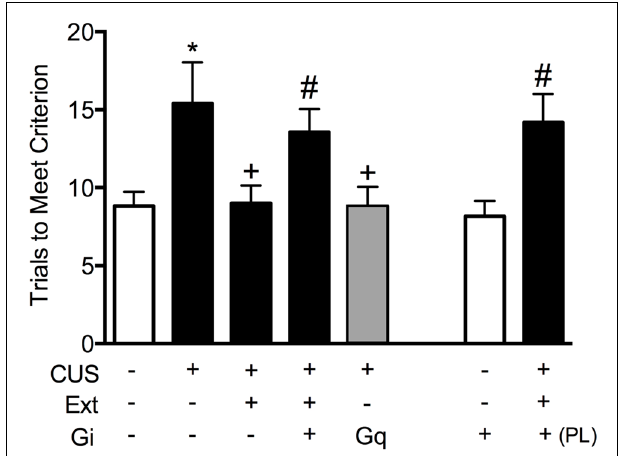
FIGURE 2 | Activity of glutamatergic pyramidal cells in the infralimbic (IL) cortex is necessary and sufficient for the therapeutic effects of extinction on cognitive set-shifting compromised by chronic stress. CUS compromised cognitive flexibility, significantly increasing trials required to meet criterion (TTC) of six consecutive correct responses on the extradimensional (ED) set-shifting task ( ∗ p < 0.05, GFP/CUS/tone controls compared with GFP/unstressed/tone controls). Both extinction treatment and hM3Dq activation with clozapine-N-oxide (CNO) reversed the effect of stress, restoring TTC to unstressed control levels ( + p < 0.05, GFP/CUS/extinction and hM3Dq/CUS compared with GFP/CUS/tone controls). hM4Di-mediated inhibition of IL projection neurons during extinction treatment prevented the therapeutic effect of extinction on set-shifting after CUS, as TTC were comparable to GFP/CUS/tone controls ( # p < 0.05, hM4Di/CUS/extinction compared with GFP/CUS/extinction). Similarly, inhibiting glutamatergic neurons in prelimbic (PL) cortex during extinction also prevented the beneficial effect on set-shifting ( # p < 0.05, hM4Di in PL/CUS/extinction compared with GFP/CUS/extinction). hM4Di-mediated inhibition of IL projection neurons alone in unstressed tone controls had no effect on set-shifting tested 24 h later; n = 5–9 per group. Data expressed as mean ± SEM. Reproduced and adapted with permission from Fucich et al.